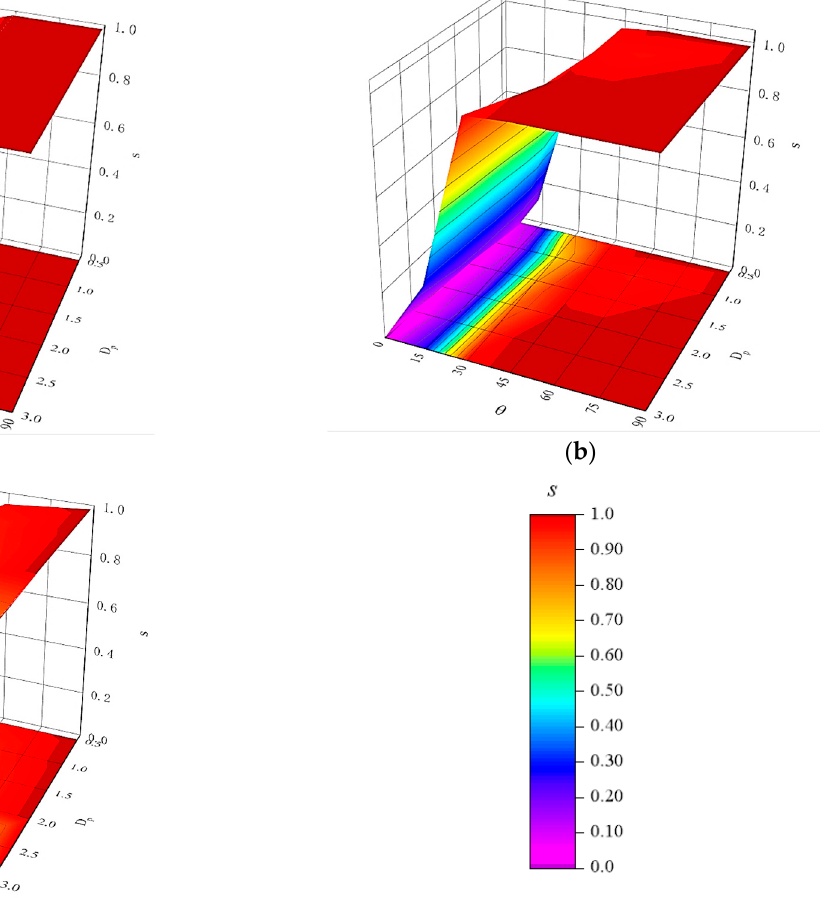
Figure 18. Variation of s with initial distance and angle under different Reynolds numbers; ( a ) Re = 1.81; ( b ) Re = 18.2; ( c ) Re